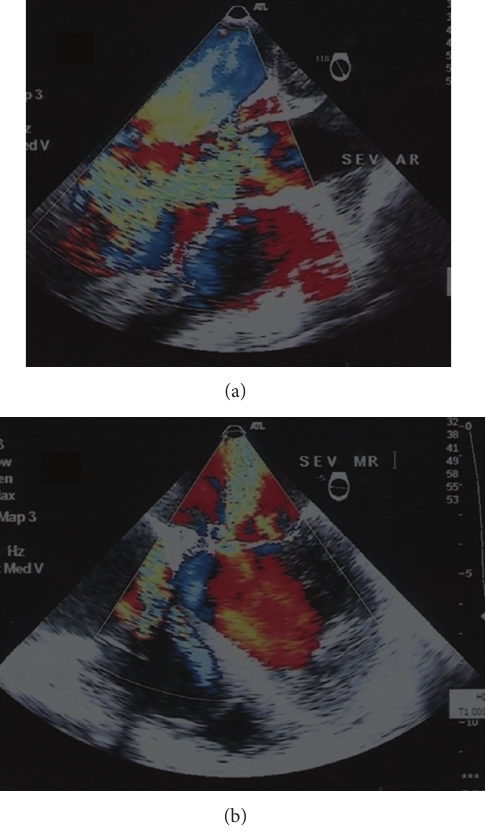
Figure 2: Midesophageal-LV long-axis view (a) and four-chamber